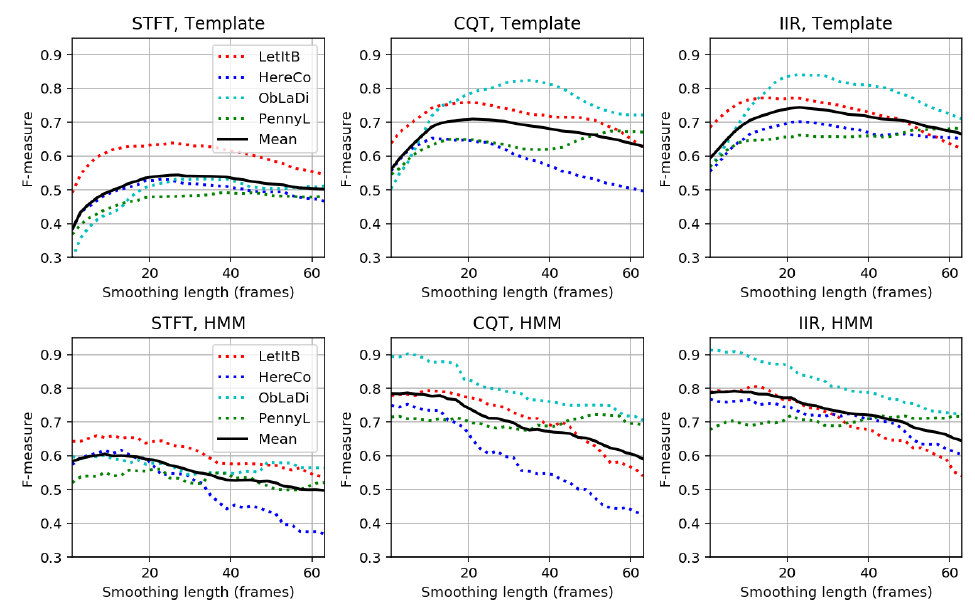
Figure 14. Prefiltering experiments for a template-based and an HMM-based chord recognizer applied to three different input chroma representations ( STFT , CQT , IIR ). The evaluation is performed on the basis of four Beatles songs ( LetItB , HereCo , ObLaDi , PennyL